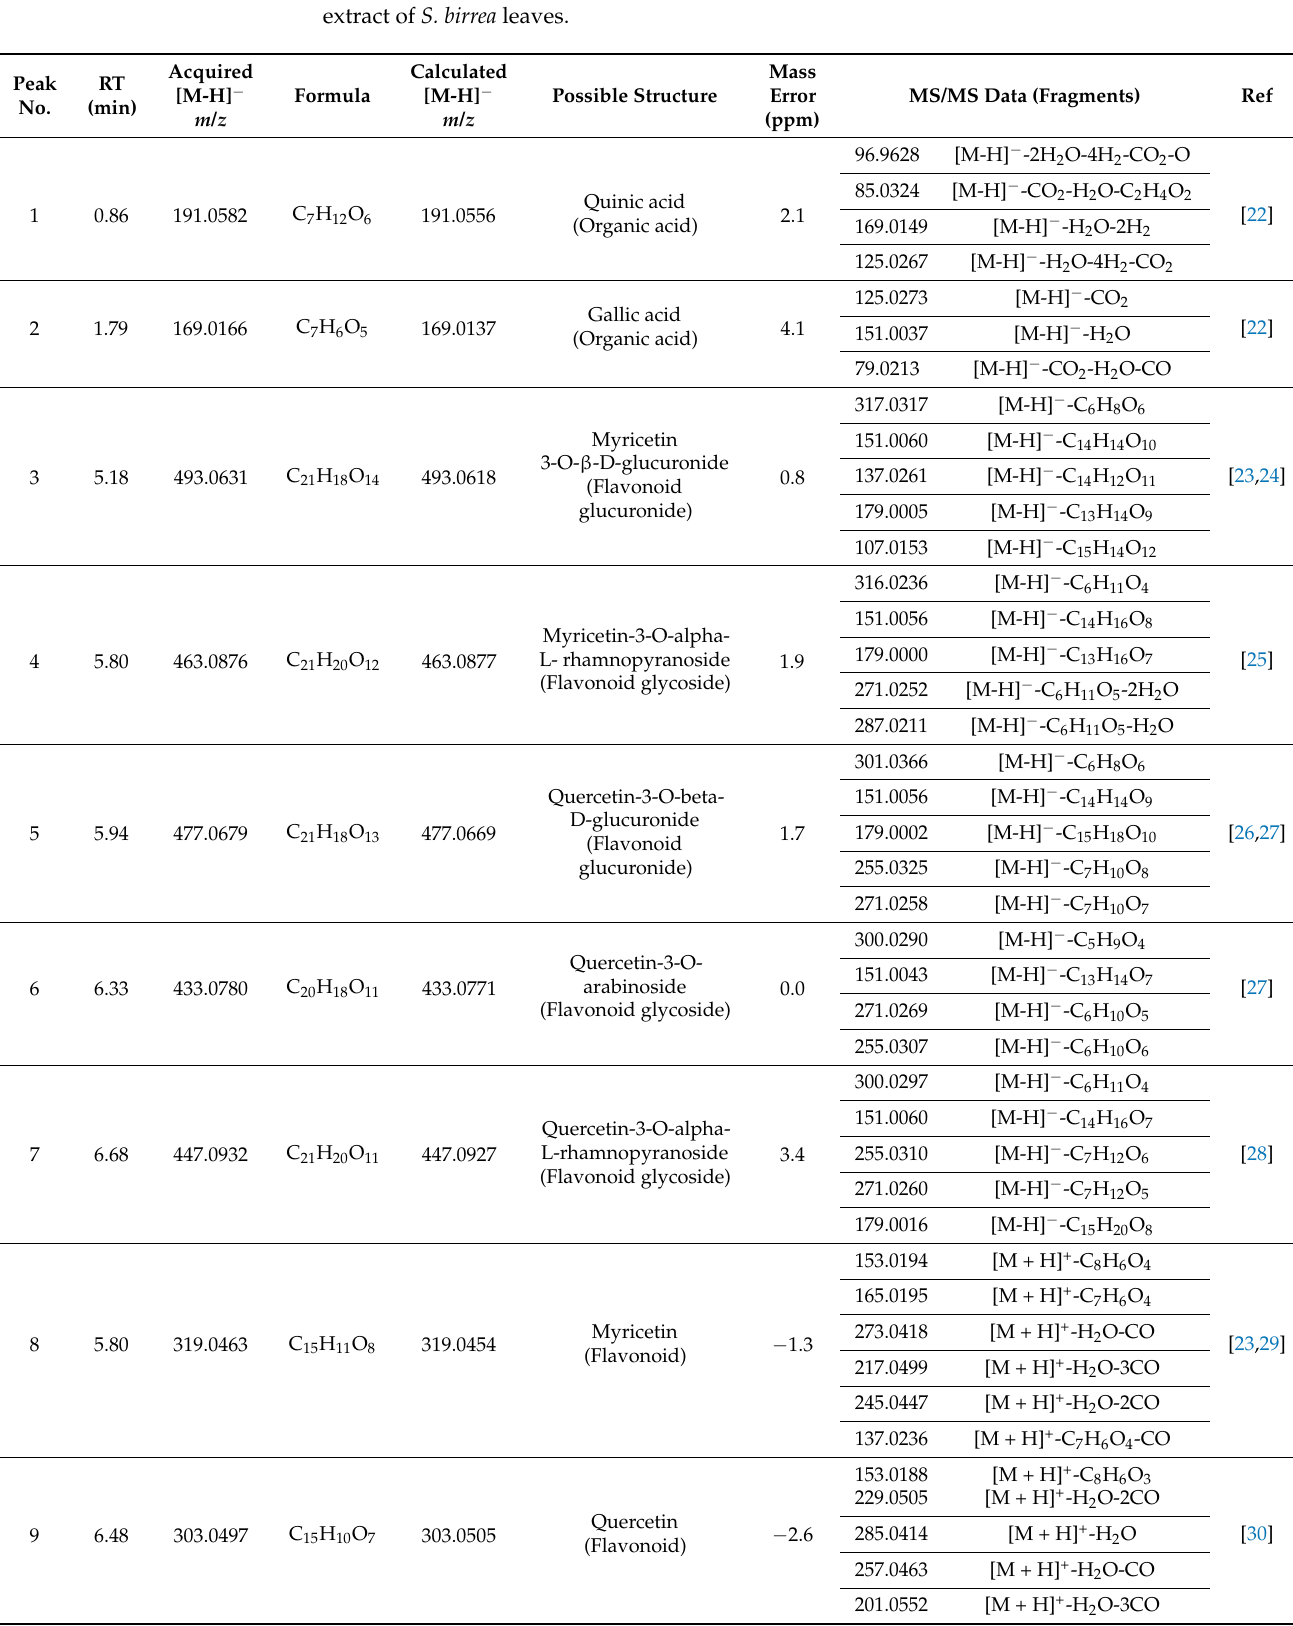
Table 2. Compounds tentatively identified using UPLC-QTOF-MS analysis of the spray dried aqueous extract of S. birrea